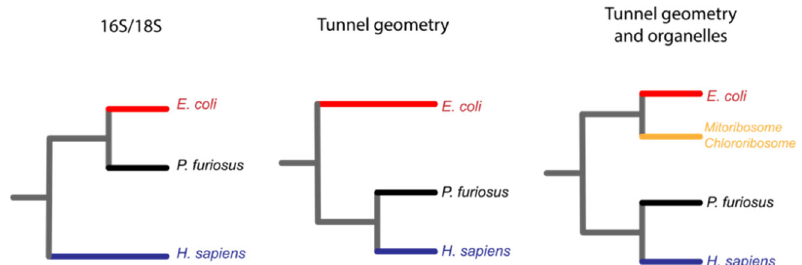
Figure 5. The geometry of the exit tunnel recapitulates the classical phylogeny of life made by sequence comparisons of 16S ribosomal RNA [58]. The classical phylogenetic tree of life is made by comparison of ribosomal 16S/18S RNA, and it allowed the creation of the three domains of life, Bacteria in red, Archaea in black and Eukarya in blue (left). Duc et al. codified into a single metric the geometry of the ribosomal exit tunnel and clustered it to recreate the three domains of life in a similar fashion (center). The same authors also included the geometry of the organelle ribosomal exit tunnels that grouped in the bacteria branch of life (right).